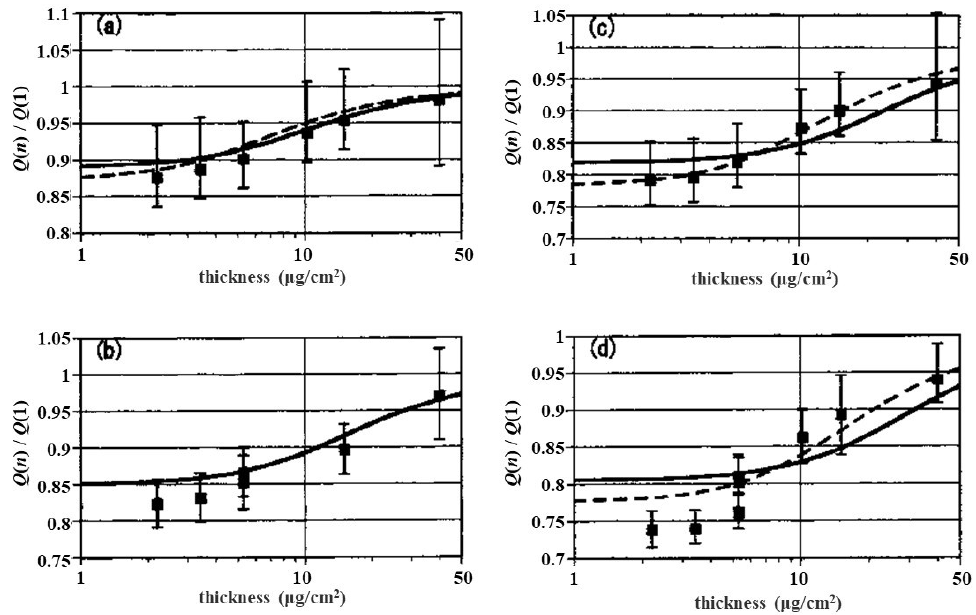
+ cluster ions, emerging